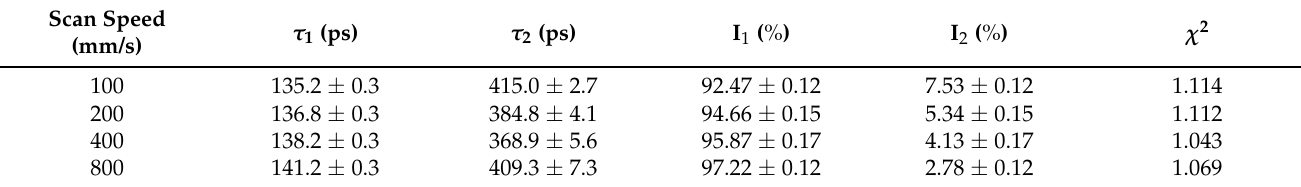
Table 5. Results of deconvolution using two unconstrained lifetime fitting parameters for LPBF Mo-0.1SiC with reduced χ 2